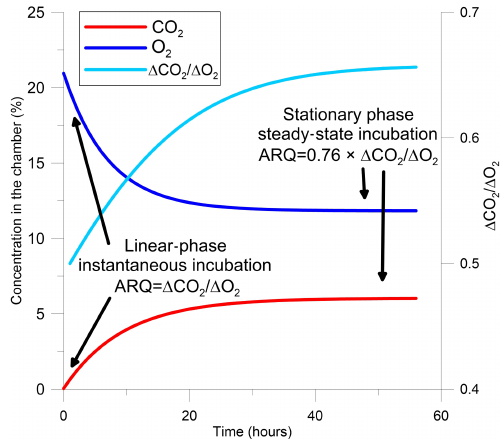
Figure 1. Modeled changes in a tree stem chamber of the concentra- tions of CO 2 , O 2 , and the ratio between (cid:49) CO 2 and (cid:49) O 2 , which are the changes in the gas concentrations from their initial values and are also the difference in concentrations between the chamber and the atmosphere. The gas dynamics are based on a one-box model with arbitrary fluxes and ARQ (ratio of CO 2 efflux / O 2 influx for tree stems) equal to 0.5. The two time frames in which ARQ can be measured from the ratio (cid:49) CO 2 /(cid:49) O 2 are indicated in the figure.